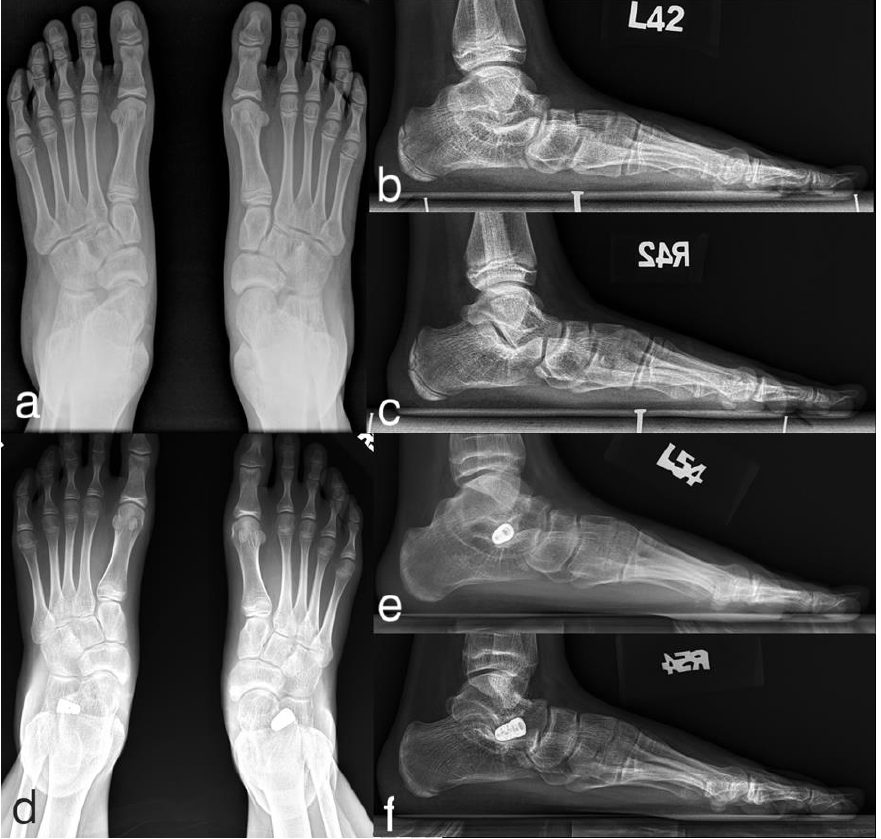
Figure 3. An 11-year-old girl with type I OI and symptomatic flexible flatfoot. The preoperative radiographs showed severe flatfoot deformity, which was significantly improved in 2-year postoperative follow-up radiographs. ( a ) Preoperative AP radiograph; ( b , c ) preoperative lateral radiograph of left and right feet; ( d ) postoperative AP radiograph; ( e , f ) postoperative lateral radiograph of left and right feet during 40-month follow-up.